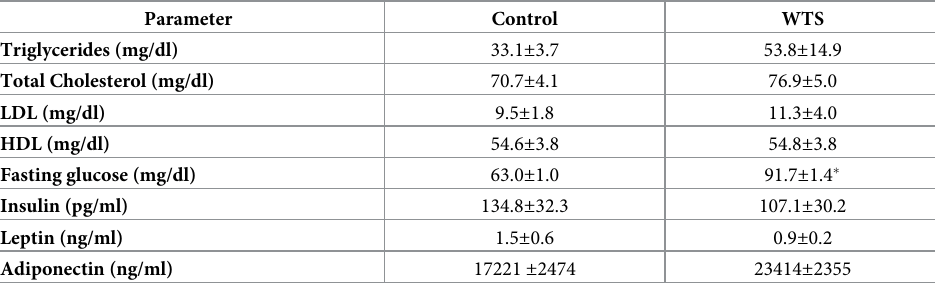
Table 2. Effect of WTS on lipid profile, glucose homeostasis and hormonal levels.